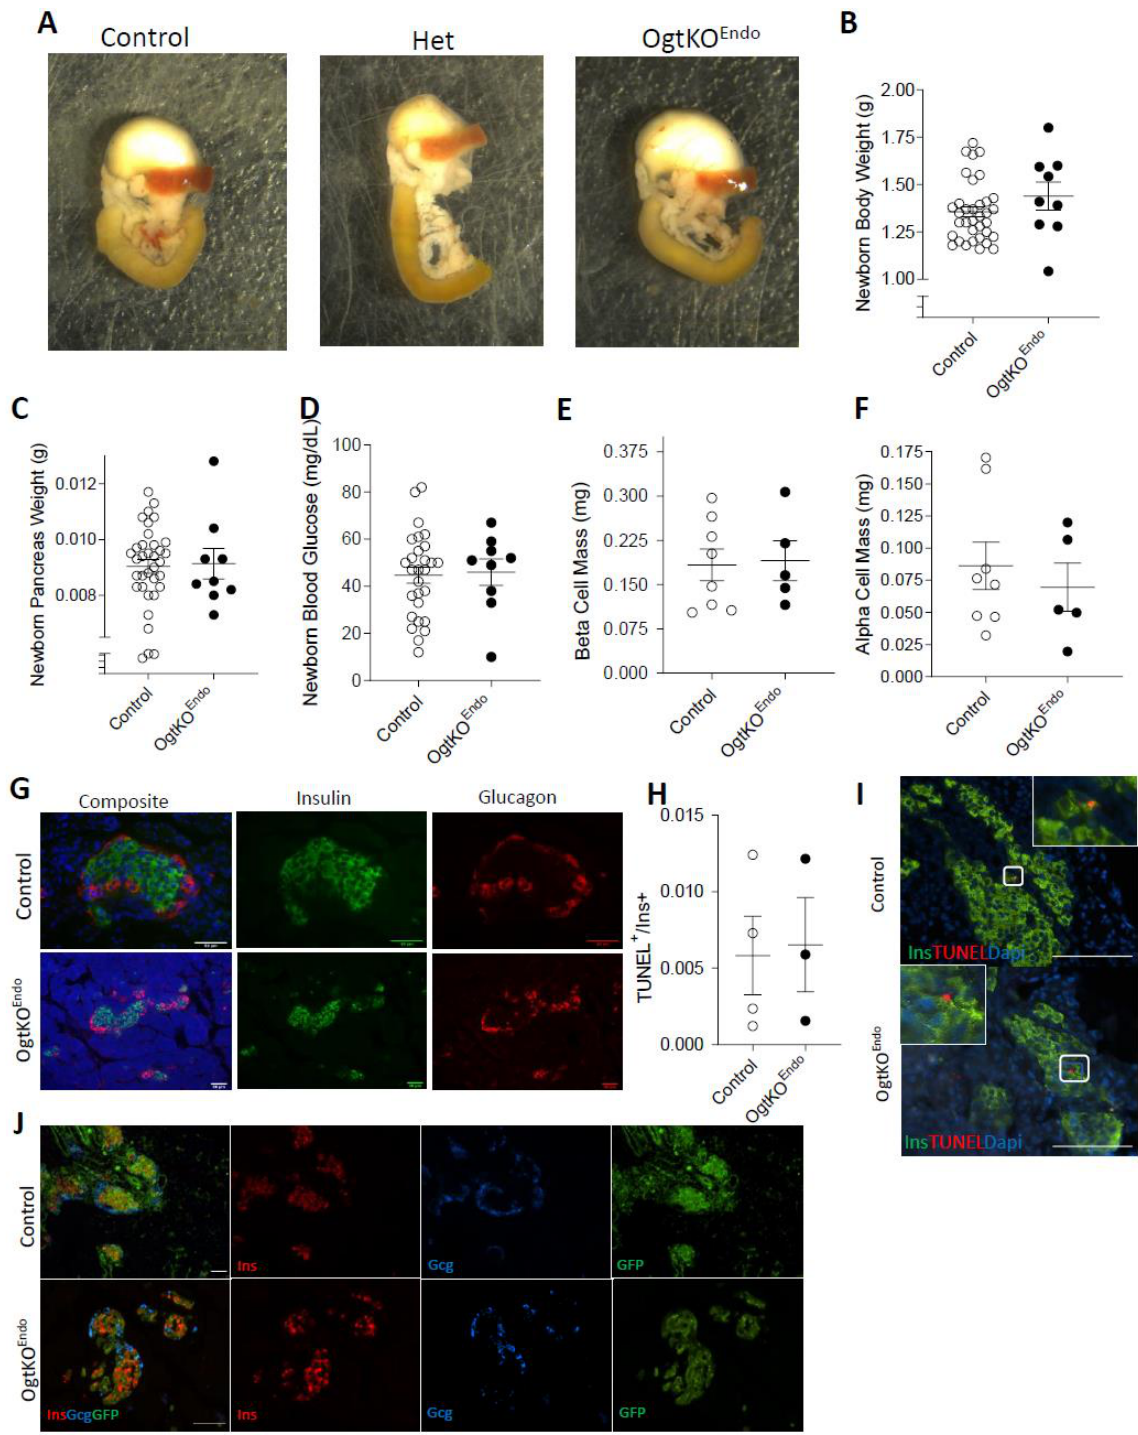
Figure 1. No morphological or metabolic changes in OgtKO Endo at birth. At p0: Gross morphology of pancreas, stomach, spleen, and duodenum ( A ), body weight ( B , n = 9 – 24), pancreas weight ( C , n = 9 – 24), and random blood glucose ( D , n = 9 – 24). Quantification of β -cell mass ( E , n = 5 – 8) and α -cell mass ( F , n = 5 – 8). Representative immunofluorescence images showing normal islet morphology ( G , Top row 40 × , bottom row 20 × , scale = 50 µ m). Quantification of apoptosis in β -cells via TUNEL ( H , n = 3) with representative images ( I , 40 × , scale = 100 µ m). CAG-EGFP reporter indicates Cre-expression in both β and α -cells ( J , 20 × , scale = 50 µ m). Statistics were performed with a Mann–Whitney U-Test (two-tailed with significance p ≤ 0.05). In all graphs, open circle = Control and closed circle = OgtKO Endo . Both male and female data